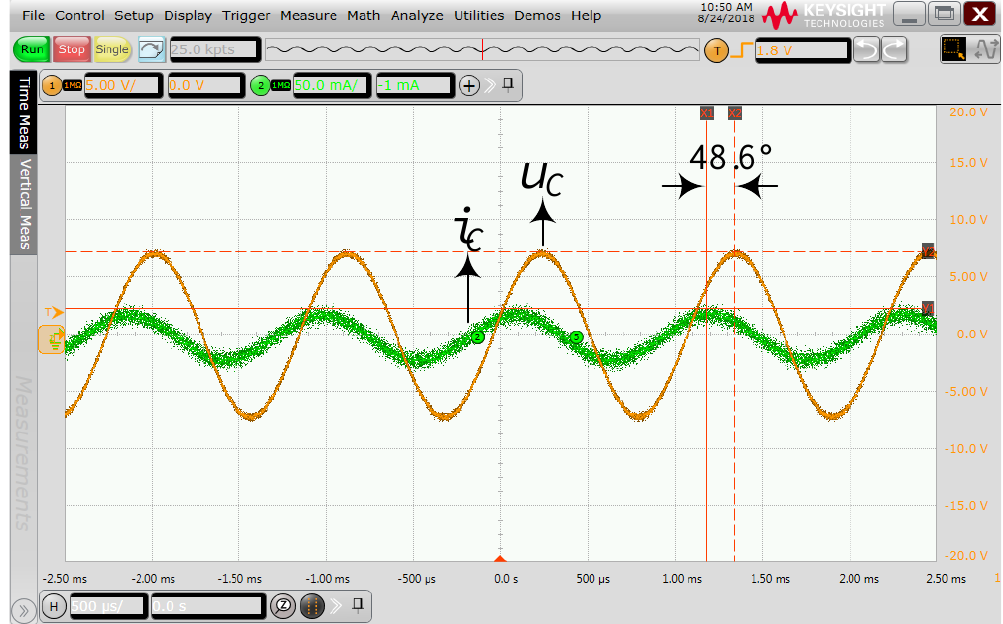
Figure 11. Experimental waveforms of